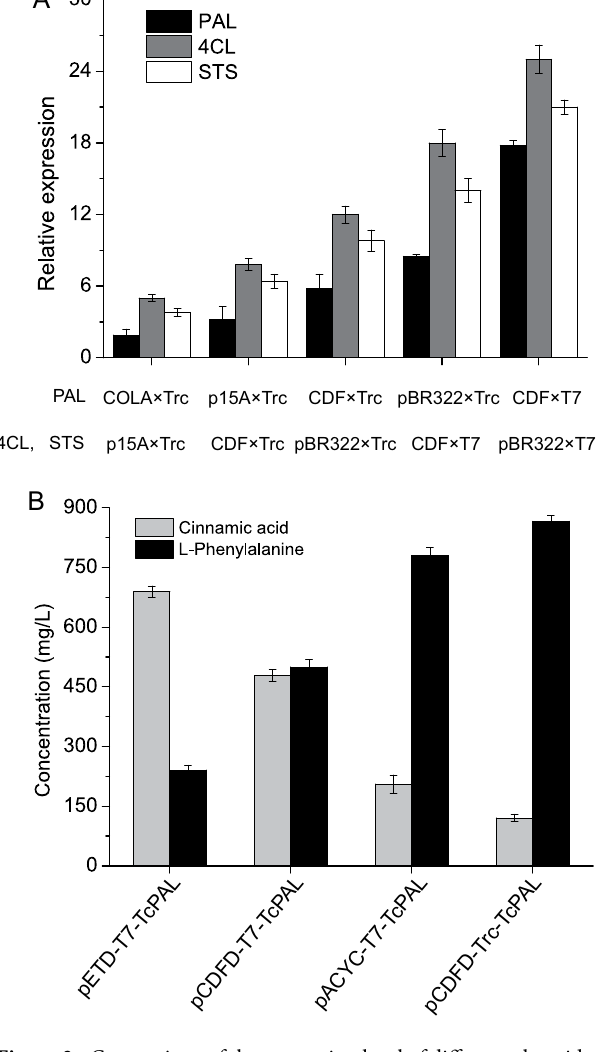
Figure 3. Comparison of the expression level of different plasmids and promoters. ( A ) RT-PCR for transcriptional analysis of heterologous genes. Transcriptional levels of PAL, 4CL and STS were measured by RT-PCR based on mRNA isolated from engineered strains. COLA × Trc, p15A × Trc, CDF × Trc, pBR322 × Trc, CDF × T7, pBR322 × T7 indicated the transcriptional level of 5 a.u., 10 a.u., 20 a.u., 40 a.u., 100 a.u., 200 a.u., respectively. ( B ) Comparison of different PAL in vivo activity under different plasmids and promoters. The plasmids of pCDFD-T7-TcPAL, pCDFD-Trc-TcPAL, pACYC-T7-TcPAL and pETD-T7-TcPAL were transformed into BL21 (DE3) strain to compare the in vivo TcPAL activity under different plasmids and promoters. These engineered strains were supplemented with 1 g/L L-phenylalanine. Values are calculated after 48 h cultivation in fermentation